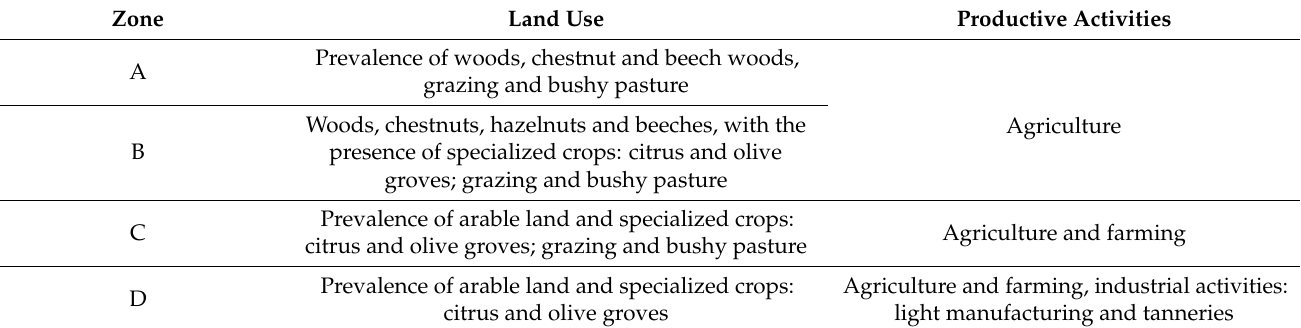
Table 3. Land use and productive activities.